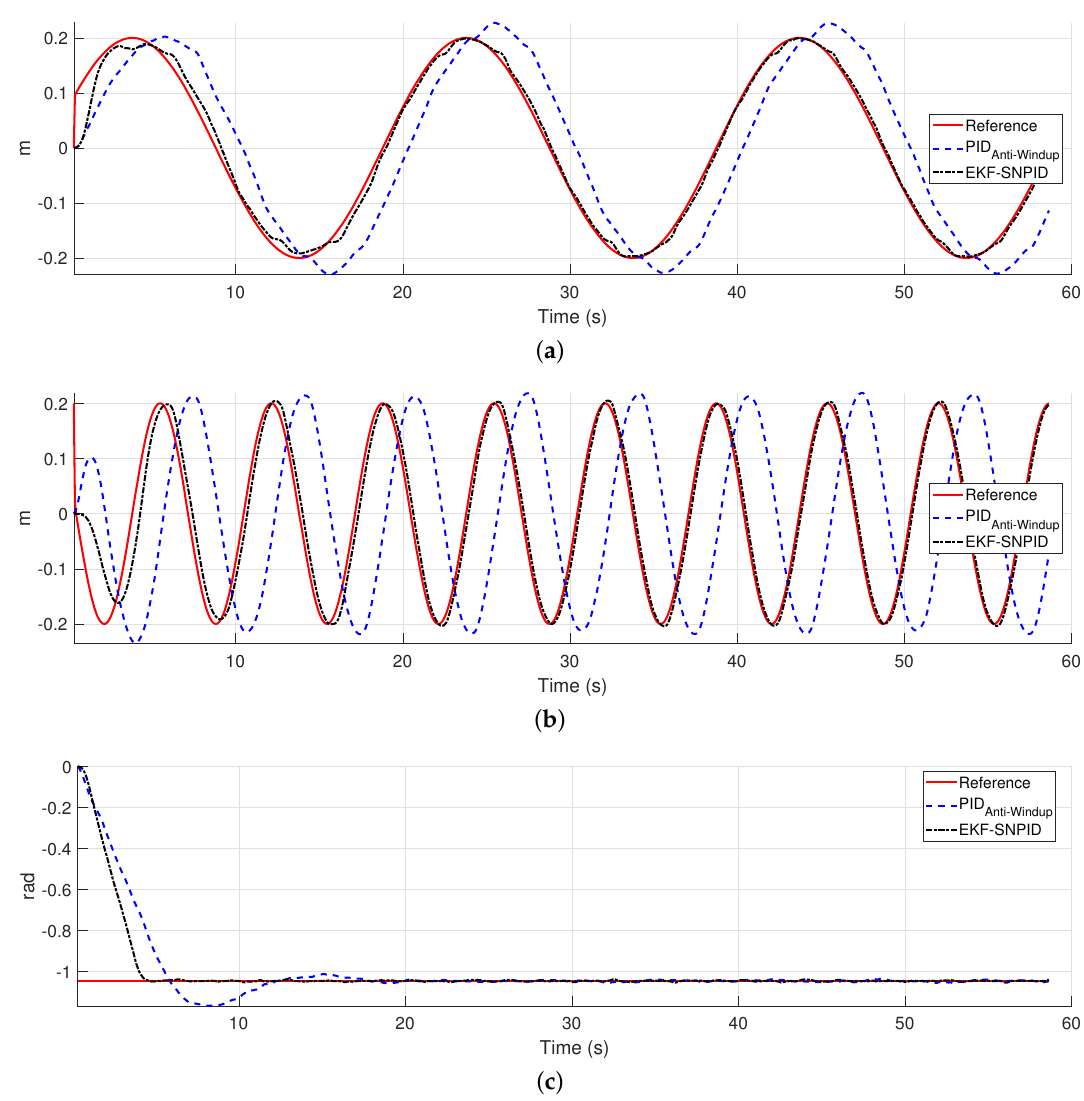
Figure 20. System response for the sinusoidal trajectory. ( a ) System response for x . ( b ) System response for y . ( c ) System response for θ